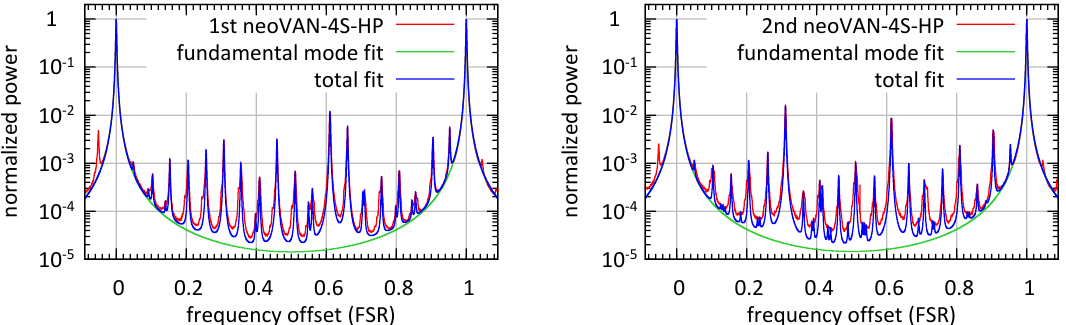
Figure 7. ( Left ) Modescan of the laser beam amplified by the first neoVAN-4S-HP amplifier. The higher order mode content of the laser beam was < 4.2%. ( Right ) DBB modescan of laser beam amplified